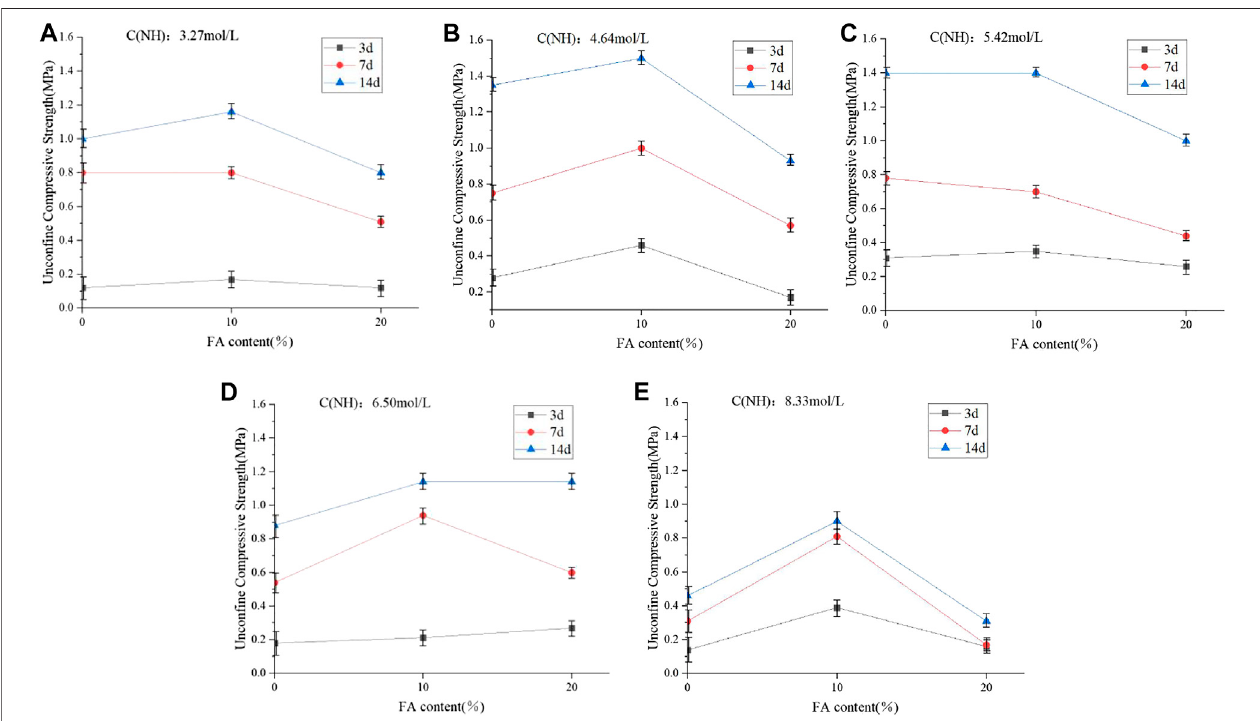
FIGURE 5 | UCS results of the one-part GGBFS-FA – based geopolymer-stabilized soil with different ratios of GGBFS to FA in the aluminosilicate raw material.